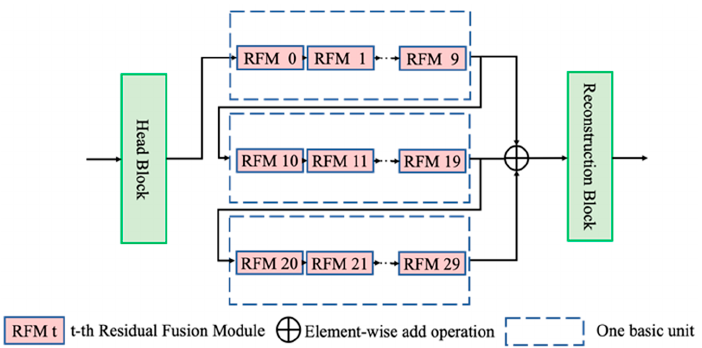
Figure 4. Overview of the body block which treats every ten RFMs as one basic unit occupying the same role as one residual block in the RFM. same role as one residual block in the